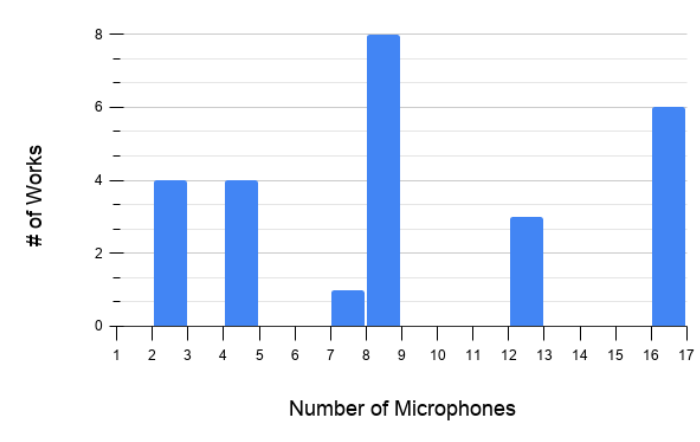
Figure 6. Number of works with respect to the number of microphones that have reported localization techniques and falling into the land-to-air category. Note that the largest number of works report the use of eight microphones, followed by sixteen